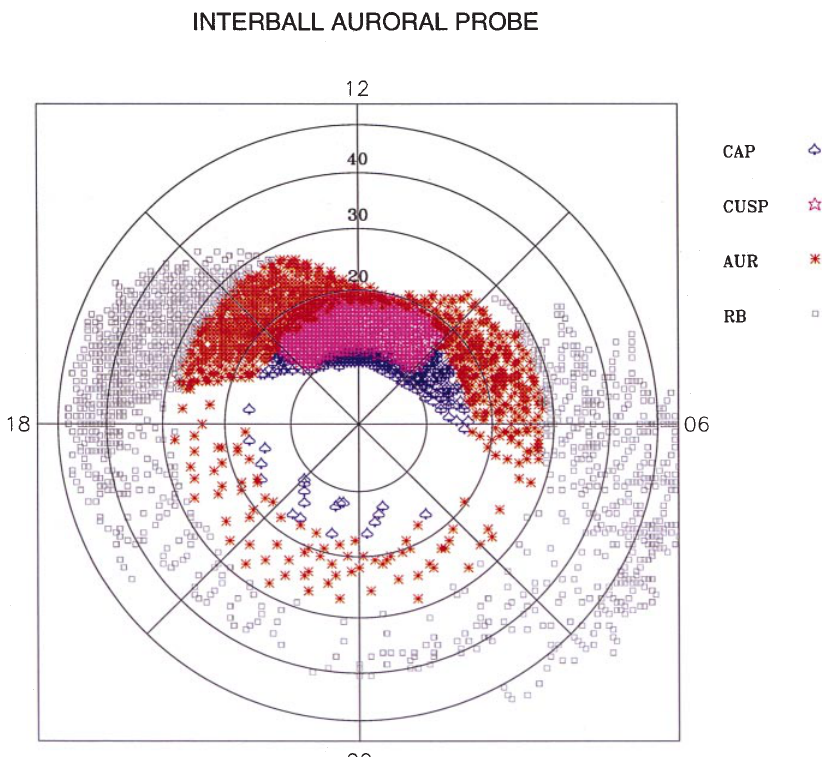
Fig. 1. Orbits of the Auroral Probe for January 1998 in a polar diagram (magnetic local time and invariant co-latitude). The symbol CAP refers to the polar cap, CUSP to the polar cusp, AUR to the auroral zone, and RB to the radiation belt. The satellite sweeps out all local times in (cid:24) 9 months. (Courtesy of